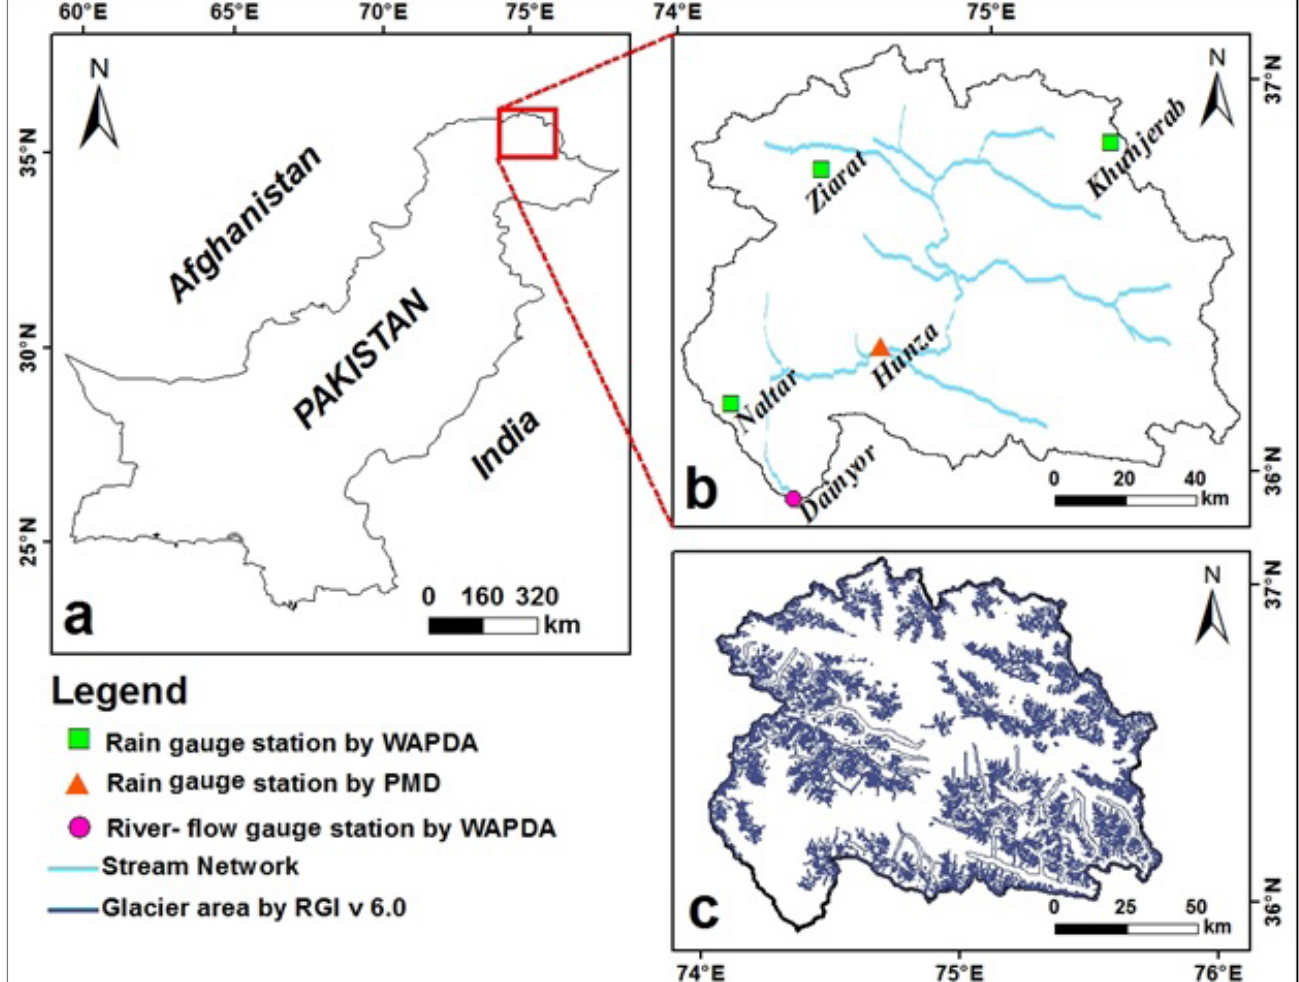
Figure 1. The project location is shown in ( a ), while the Hunza River basin is shown in ( b , c ); in sub- figure c the glacier area is derived from